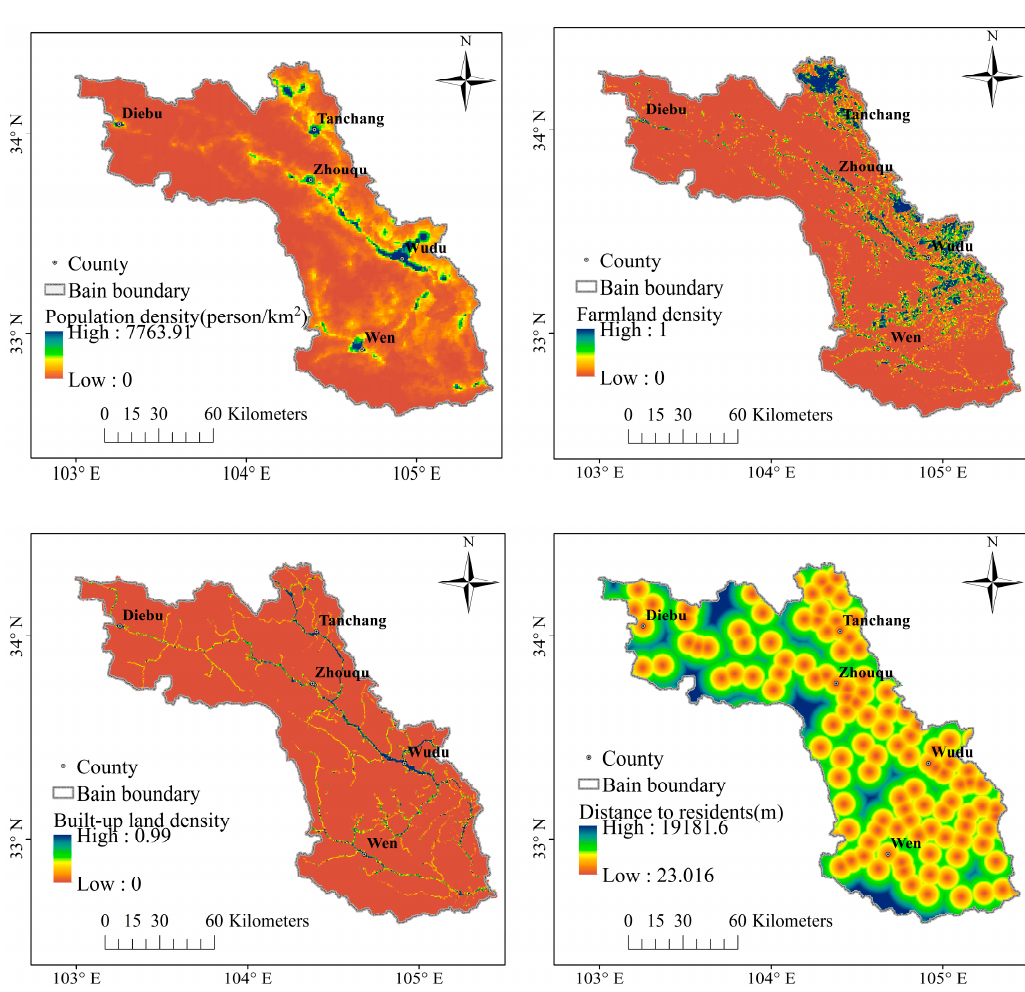
Figure 6. Distribution of factors related to rain conditions.